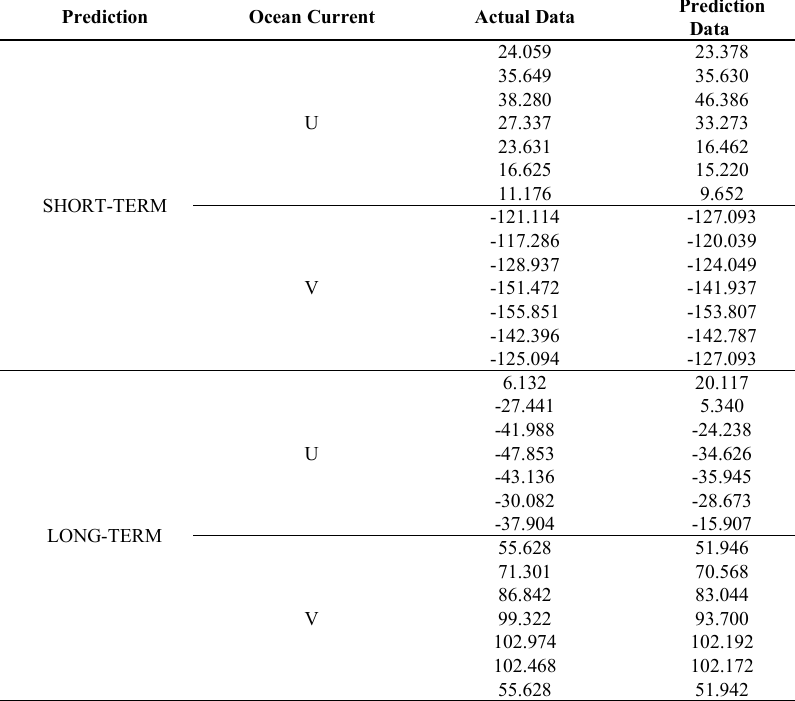
TABLE 5 S HORT - TERM AND LONG - TERM PREDICTION V ALUE O F U AND